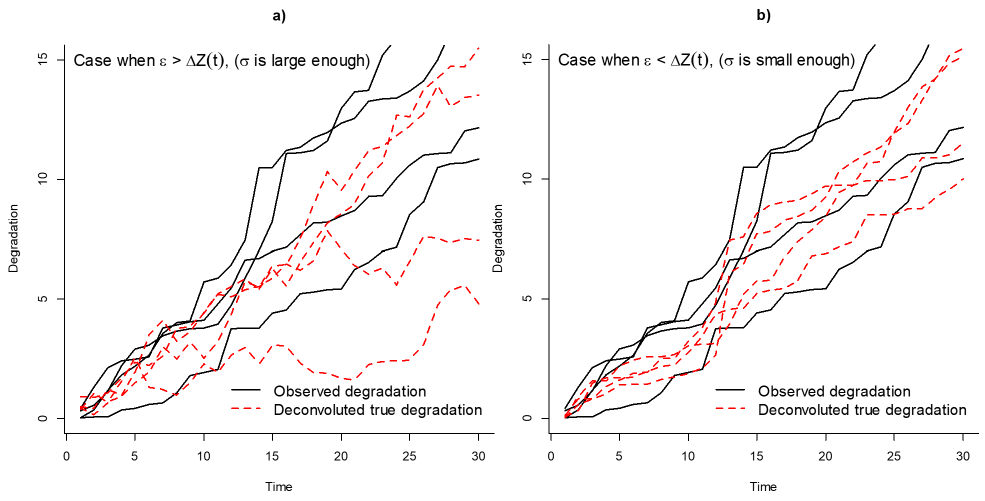
Figure 1. Comparison of degradation paths for observed and true degradation. ( a ) True non-monotone degradation paths in red dotted lines when ∆ Z i dotted lines when ∆ Z i